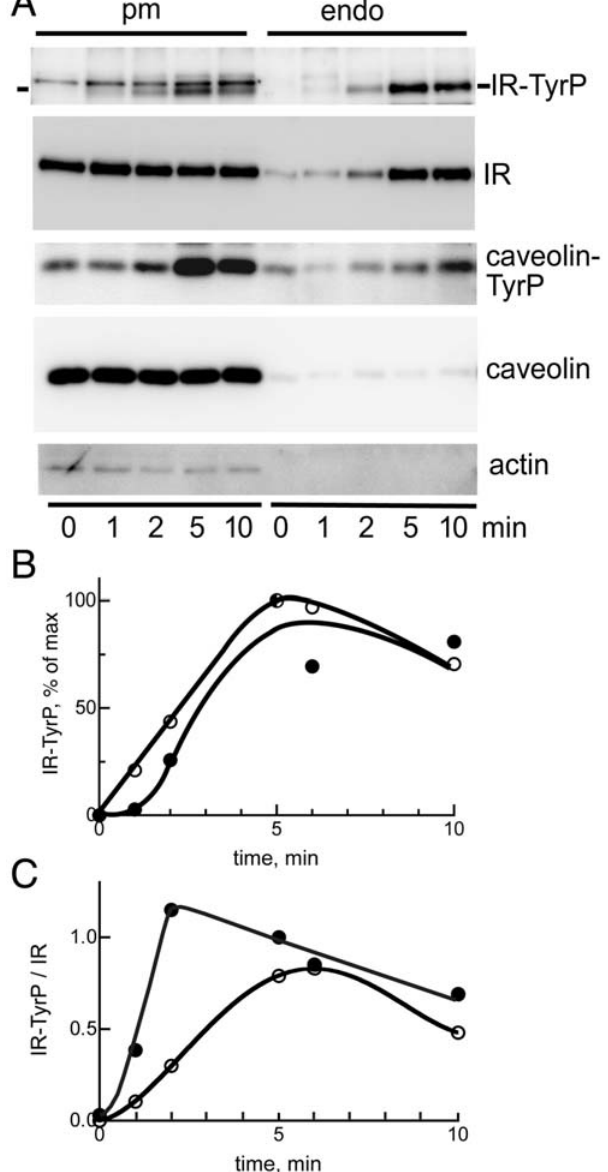
Figure 1. Phosphorylation and endocytosis of the insulin receptor. Isolated adipocytes were incubated with 100 nM insulin for the indicated time, when cells were homogenized and plasma membrane (pm) and endosomal (endo) fractions isolated. A. Equal amounts of protein (5 m g) were subjected to SDS-PAGE and immuno- blotting with (from the top) antibodies against phosphotyrosine (indicated is the insulin receptor, IR-TyrP, identified by its comigration with insulin receptor protein on the same blot), insulin receptor b - subunit (IR), tyrosine(14)-phosphorylated caveolin-1 (caveolin-TyrP), caveolin-1, and actin. B, C. Time-course for internalization of phosphorylated insulin receptor. Two experiments were quantified and the average of the two is presented as percent of maximal insulin effect on phosphorylation of the insulin receptor at tyrosine (IR-TyrP) ( B ) or as a ratio of IR-TyrP to the amount of insulin receptor b -subunit protein (IR) ( C ), in the plasma membrane (open symbols) and endosomal fraction (closed symbols).